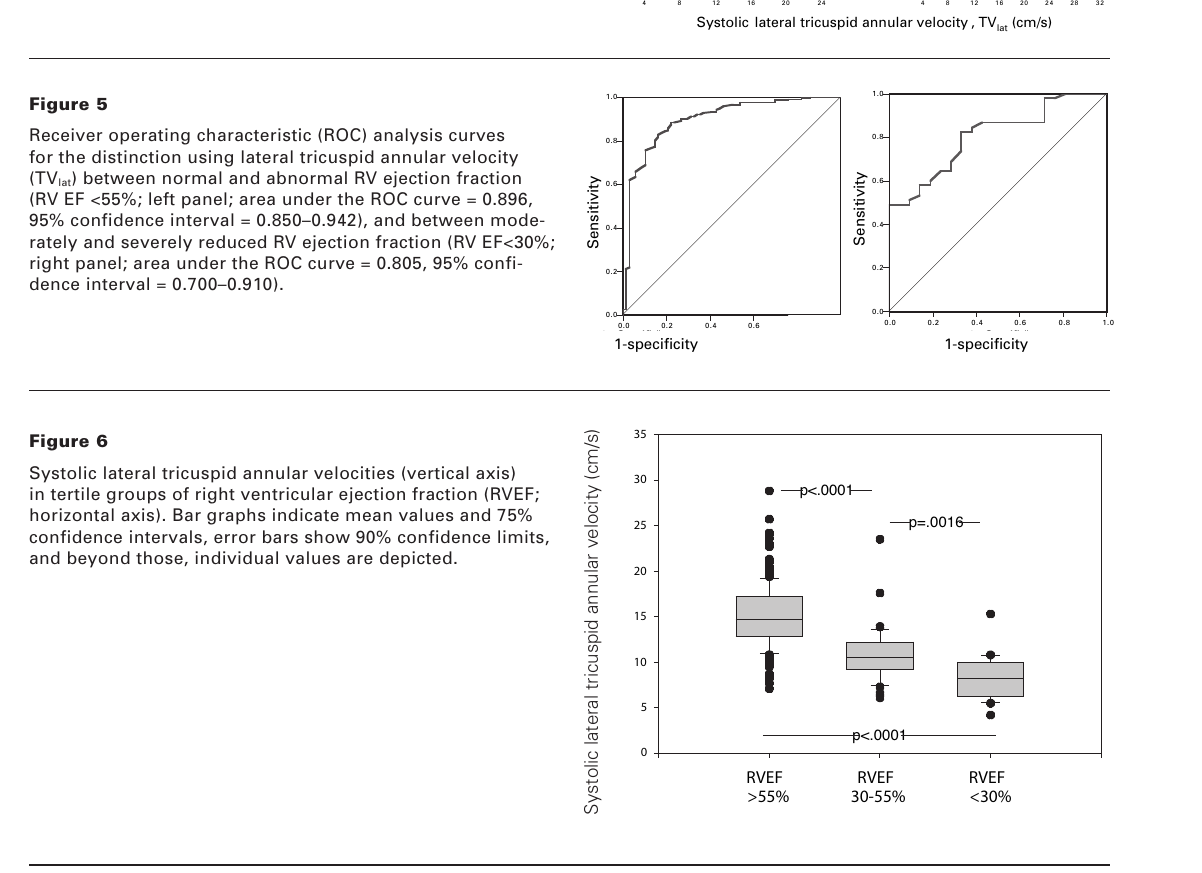
Systolic lateral tricuspid annular velocity, TV lat (cm/s)